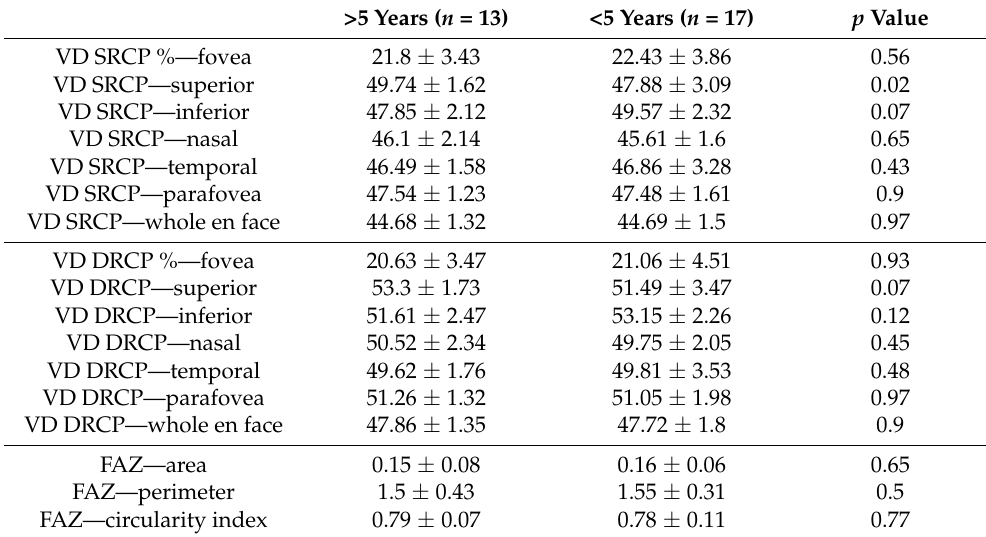
Table 4. Comparison of OCTA parameters among SLE patients based on HCQ treatment